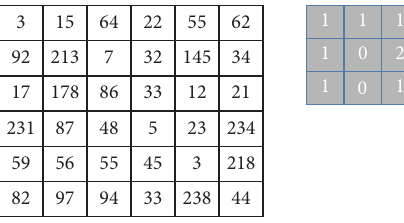
Figure 4: Digital image representation and convolution matrix.